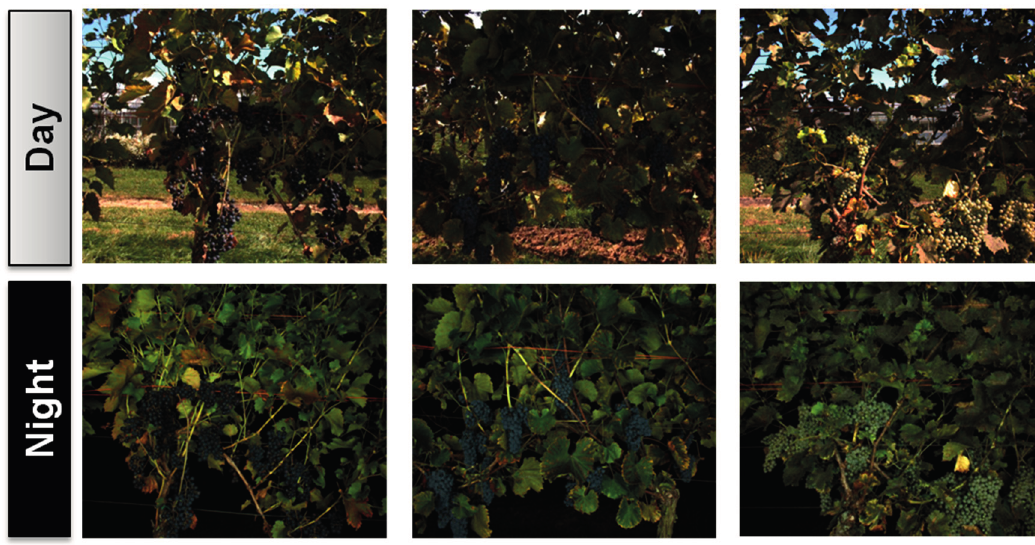
Figure 4. Comparison of images taken during the day and at night. Three examples of vines photographed on a sunny day and at night. All images were captured using the PHENObot with the lightning unit on. Image acquisition at night enables standardized conditions, which are very important for robust automated image analysis and comparable phenotyping results, e.g., with regard to the determination of berry